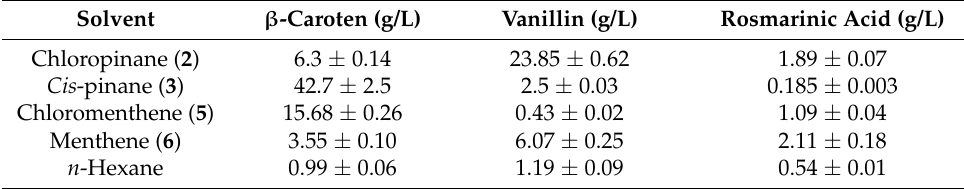
Table 2. Solubility of β -caroten, vanillin, and rosmarinic